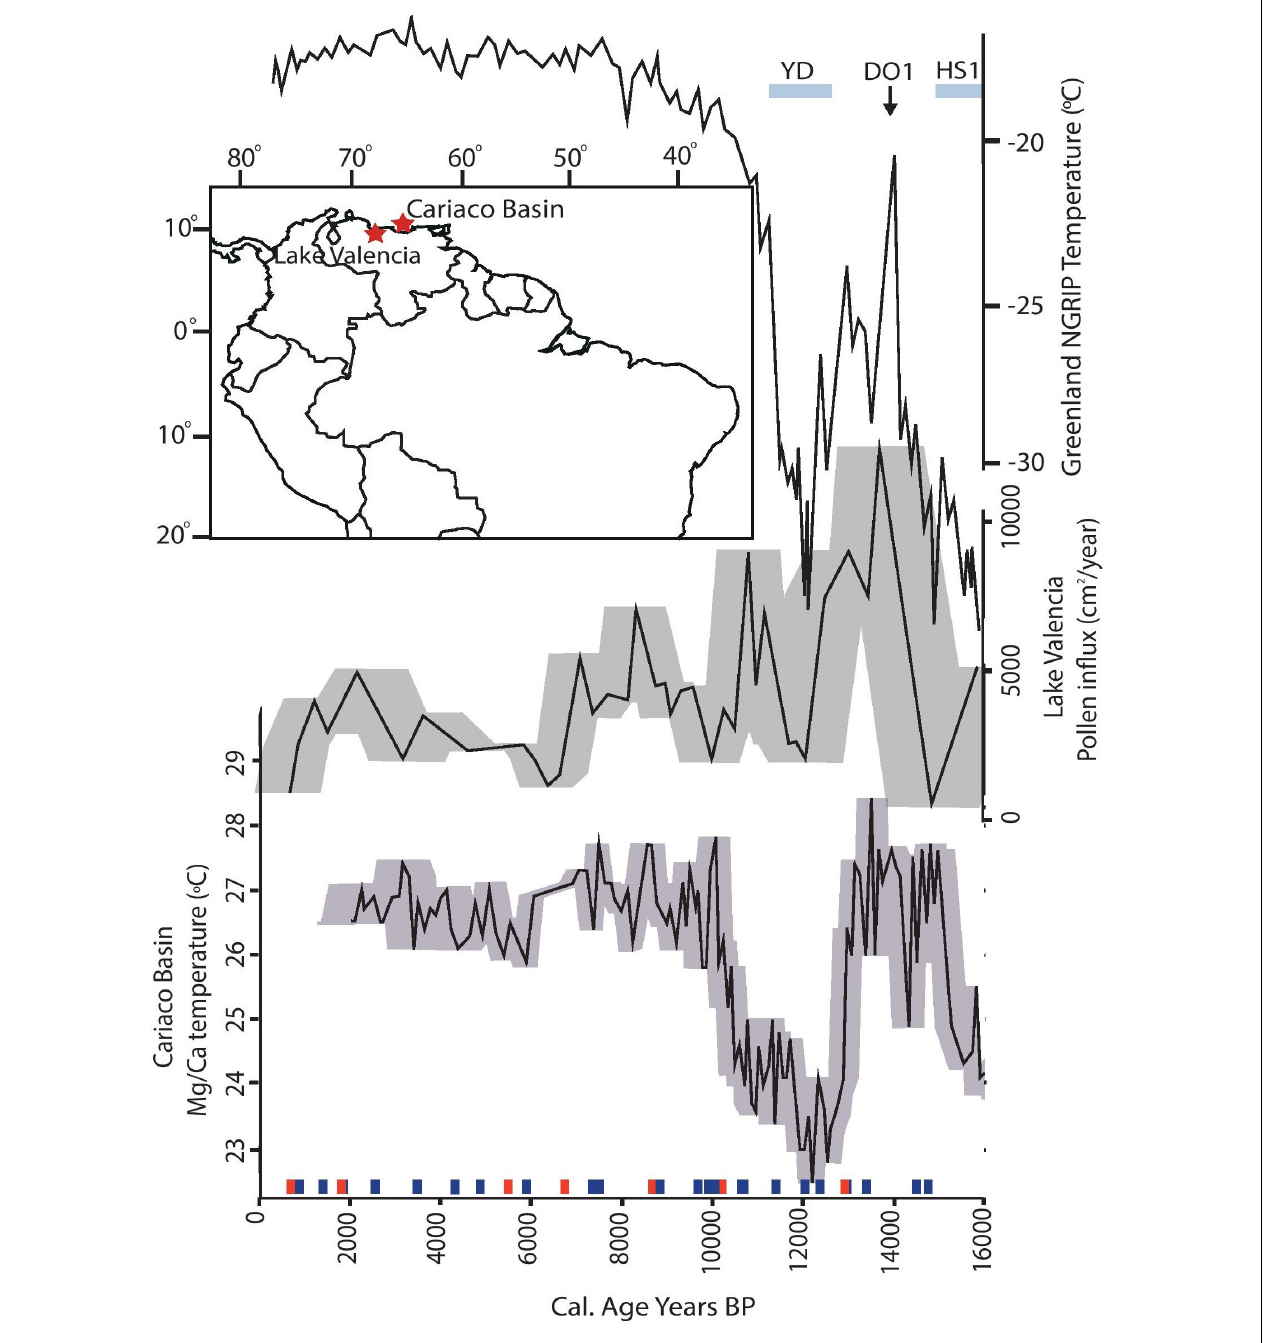
FIGURE 4 | Effects of chronological uncertainties on two neighbouring continental and ocean records of abrupt climate changes. Top: Greenland NGRIP temperature reconstruction. Middle: vegetation change recorded in the pollen record of Lake Valencia (Bradbury et al., 1981). Bottom: sea surface Magnesium/Calcium temperature reconstruction from the Cariaco Basin (Lea et al., 2003), grey bands indicate the age ± error. Radiocarbon-dated intervals are represented by red (Bradbury et al., 1981) and blue (Lea et al., 2003) rectangles. Vertical bars indicate periods of warming and cooling using the North Atlantic chronology from Sánchez Goñi and Harrison (2010). DO1, Dansgaard-Oeschger event 1; YD, Younger Dryas; and HS1: Heinrich stadial 1.